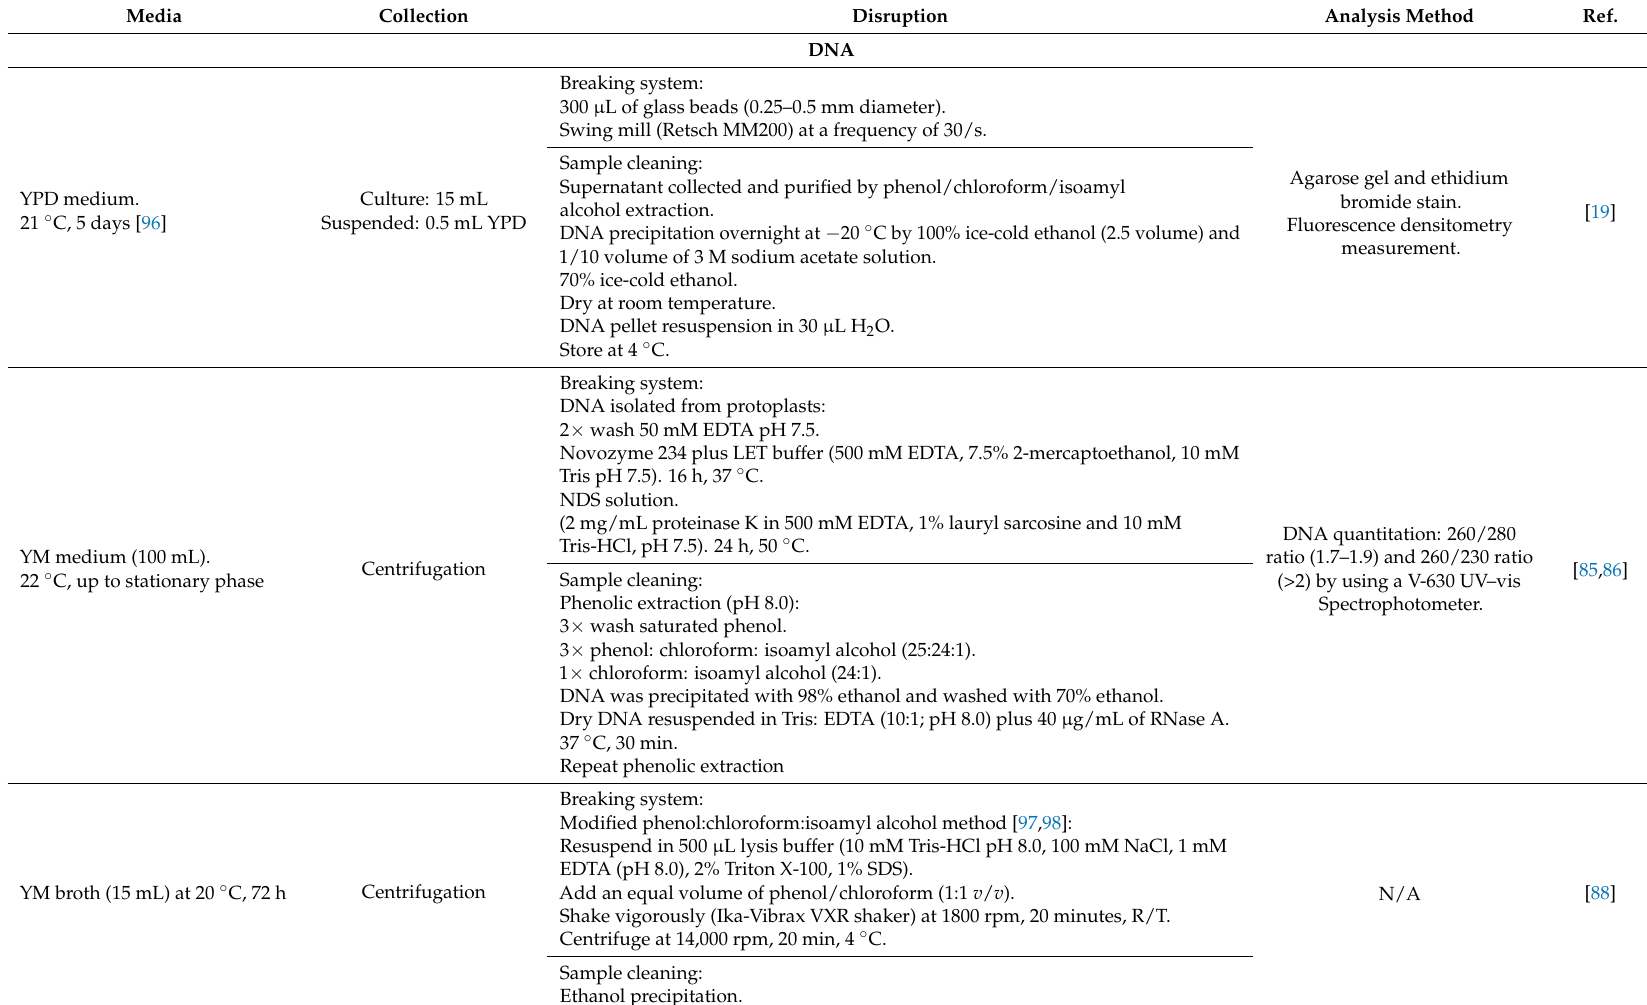
Table 2. Summary of the biomolecules extraction protocols described for X. dendrorhous ( P. rhodozyma